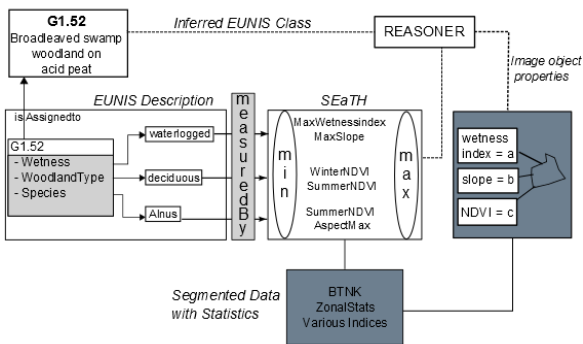
Figure 5: Overview of ontology-based